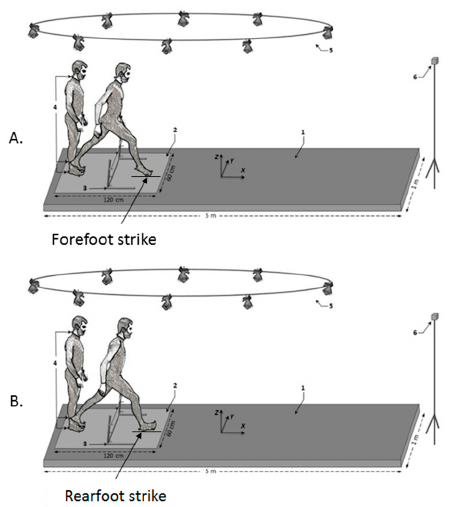
Figure 1. Schematic illustration of the experimental setup. ( A ) Gait initiation with a forefoot strike (FFS) pattern. ( B ) Gait initiation with a rearfoot strike (RFS) pattern. 1, walkway; 2, force plate; 3, obstacle; 4, reflective marker; 5, Vicon camera; 6, visual target.